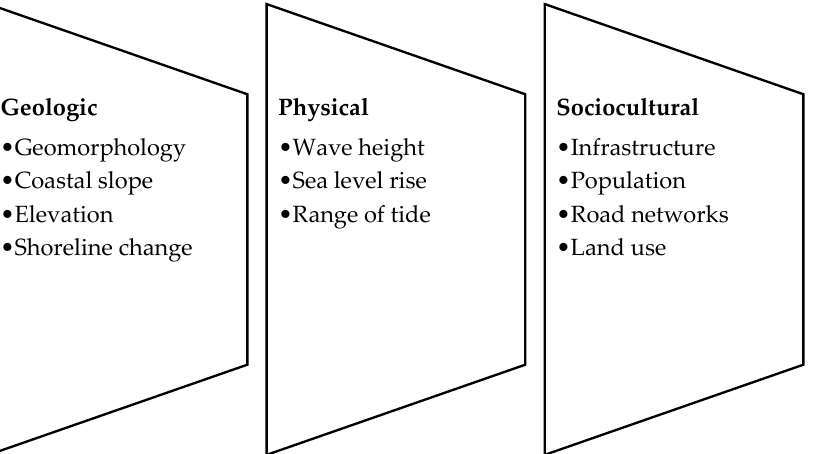
Figure 3. The most essential geologic, physical, and sociocultural factors that are used to determine coastal vulnerability.